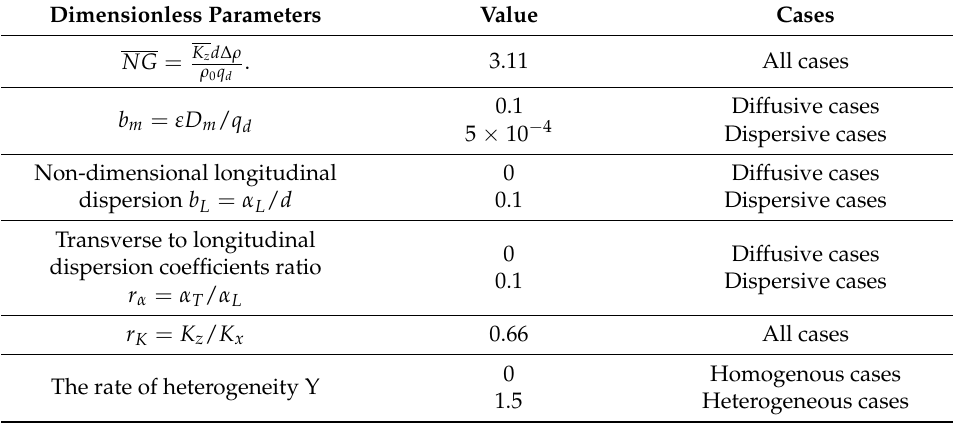
Table 2. Physical parameters used in the numerical model for the verification test